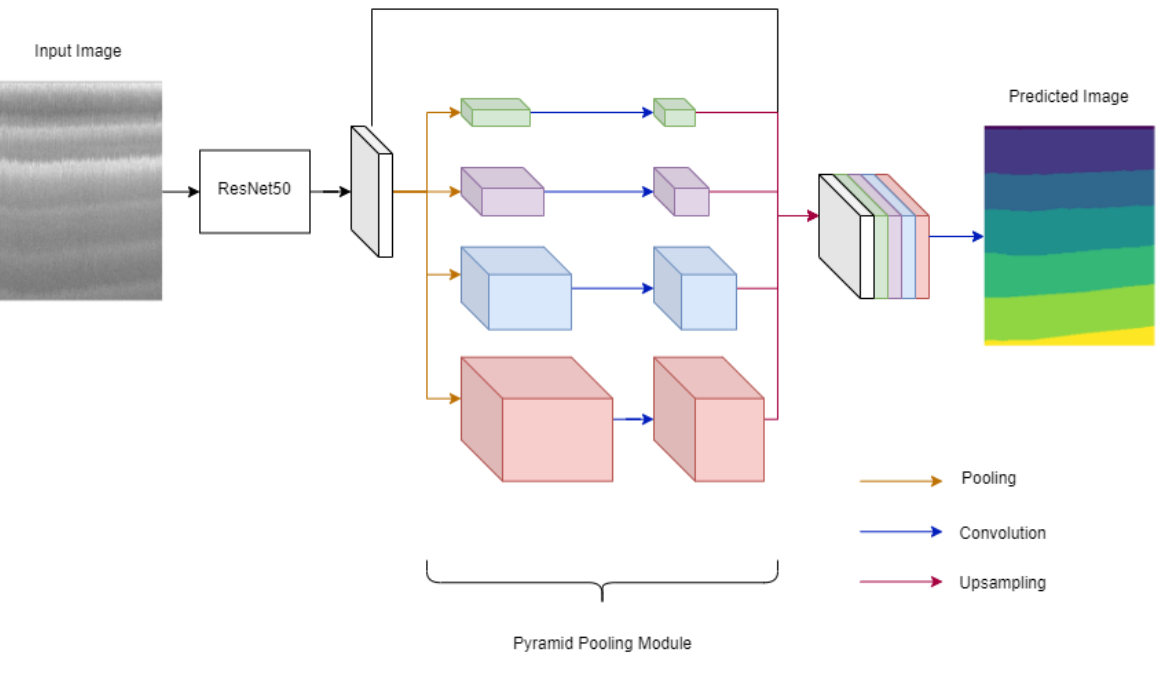
Figure 7. PSPNet [26]